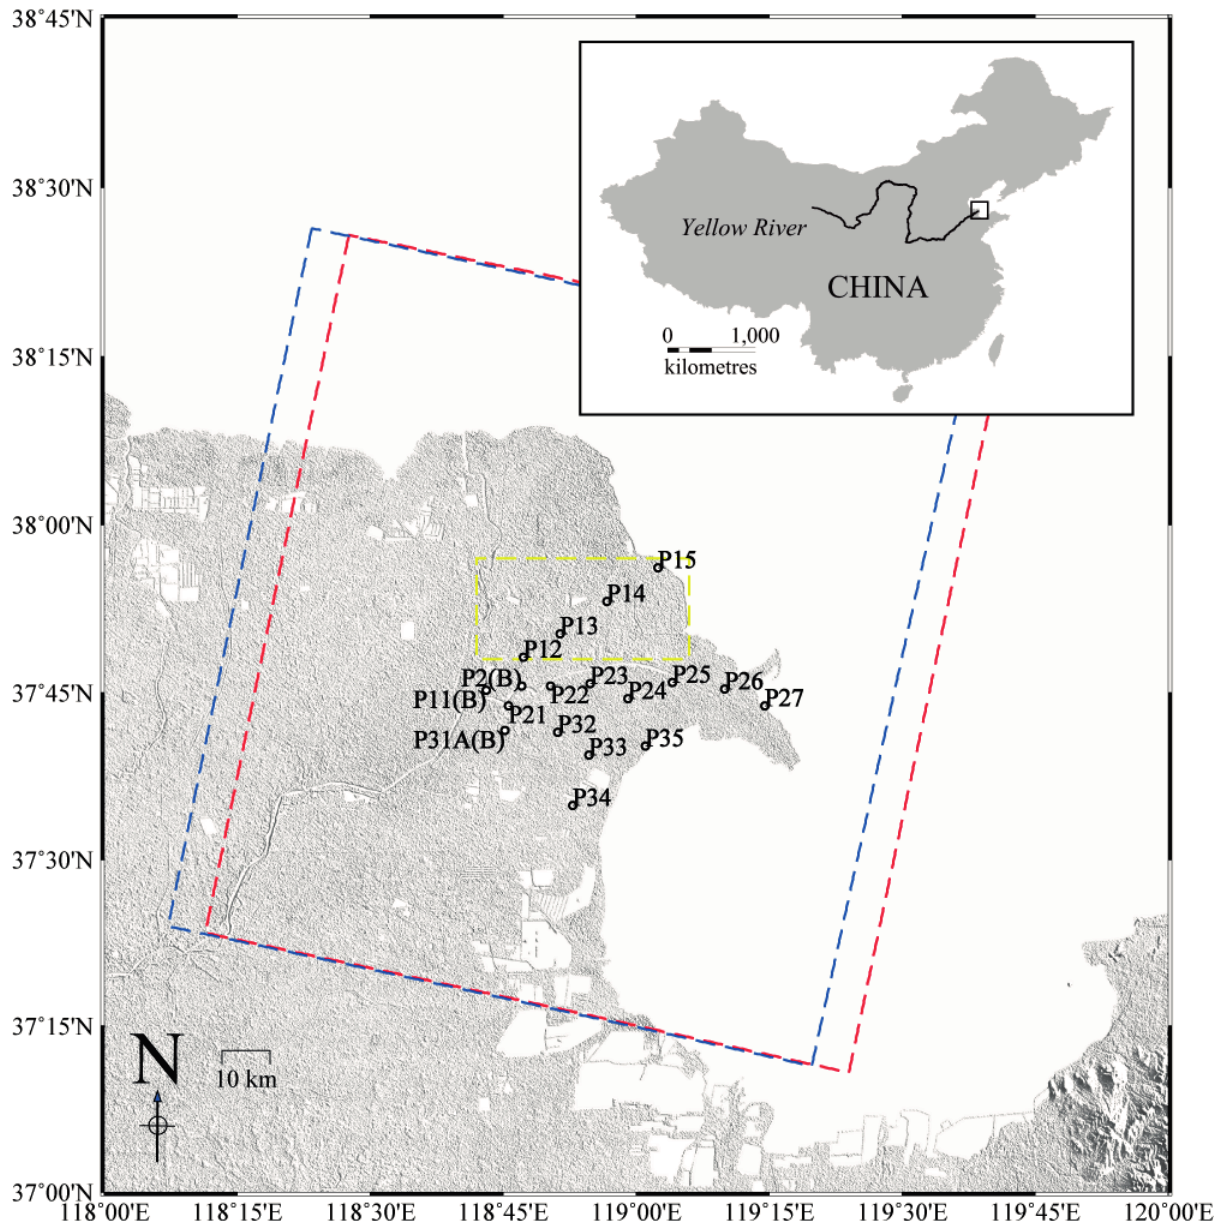
Figure 1. Location of the study area (black dashed rectangle). The red and blue dashed rectangles are Track 132 and Track 404 from Envisat Satellite, respectively. Sampling locations in the Yellow River delta are marked. Background is SRTM [24]. White areas are water surfaces (ocean and ponds). The location of the Yellow River is highlighted on the DEM by dikes built for flood